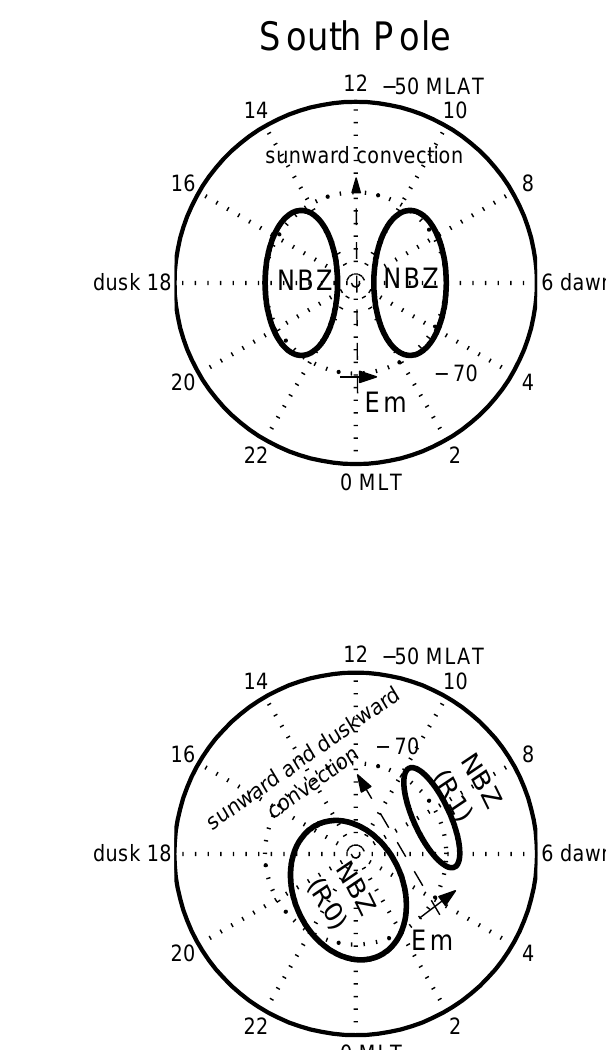
indicate the lobes while the red regions (high plasma pres- sure) in between the lobe regions indicates the plasma sheet. Under northward IMF, newly created opened field lines are symmetric with respect to the noon-midnight meridian (Z axis), but asymmetric with respect to the dawn-dusk merid- ian (Y axis). The plasma sheet extends more to the south lobe region. This makes the closed polar cap on the night- side in the south pole. The closed polar cap on the nightside may be associated with the theta aurora (Frank et al., 1982; Ogino et al., 1985; Eriksson et al., 2005). Previous studies also show that theta aurora tends to occur only in the sum- mer hemisphere (Østgaard et al.,